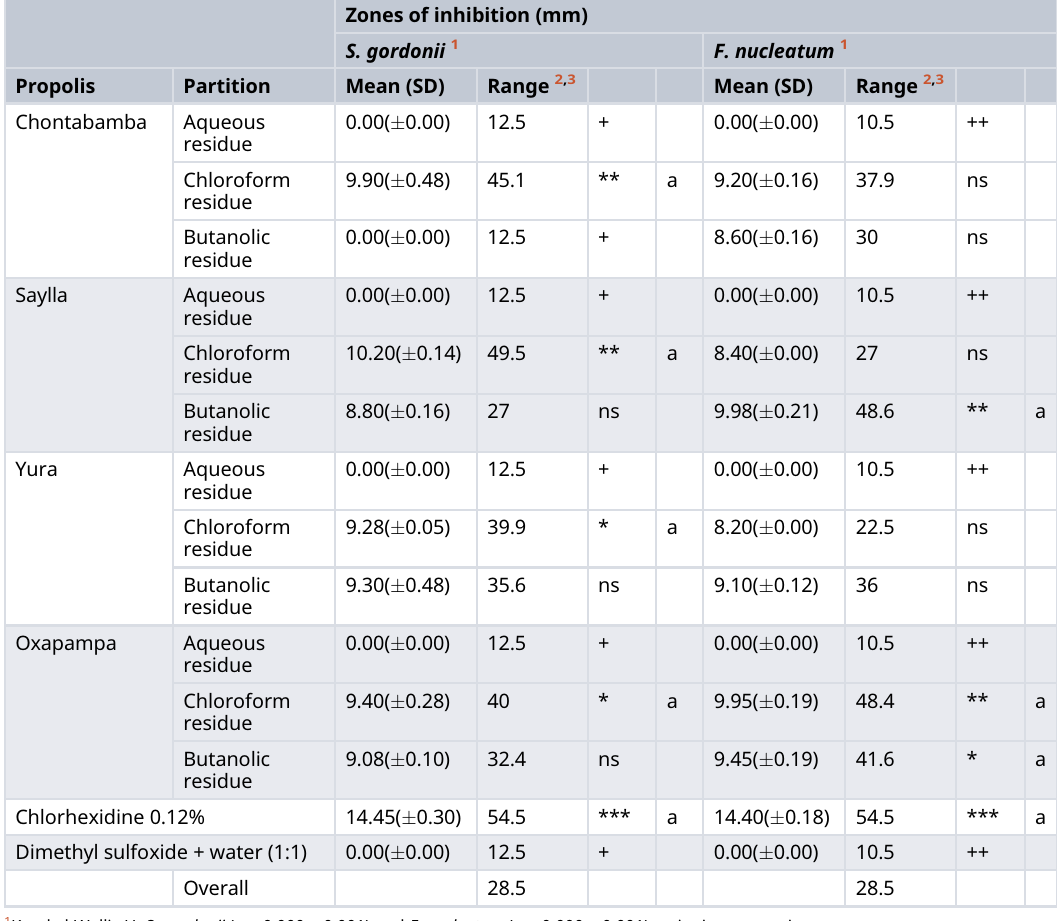
Table 3. Antibacterial effects of the partitions of crude extracts of Peruvian propolis showing antibacterial activity against S. gordonii and F. nucleatum.